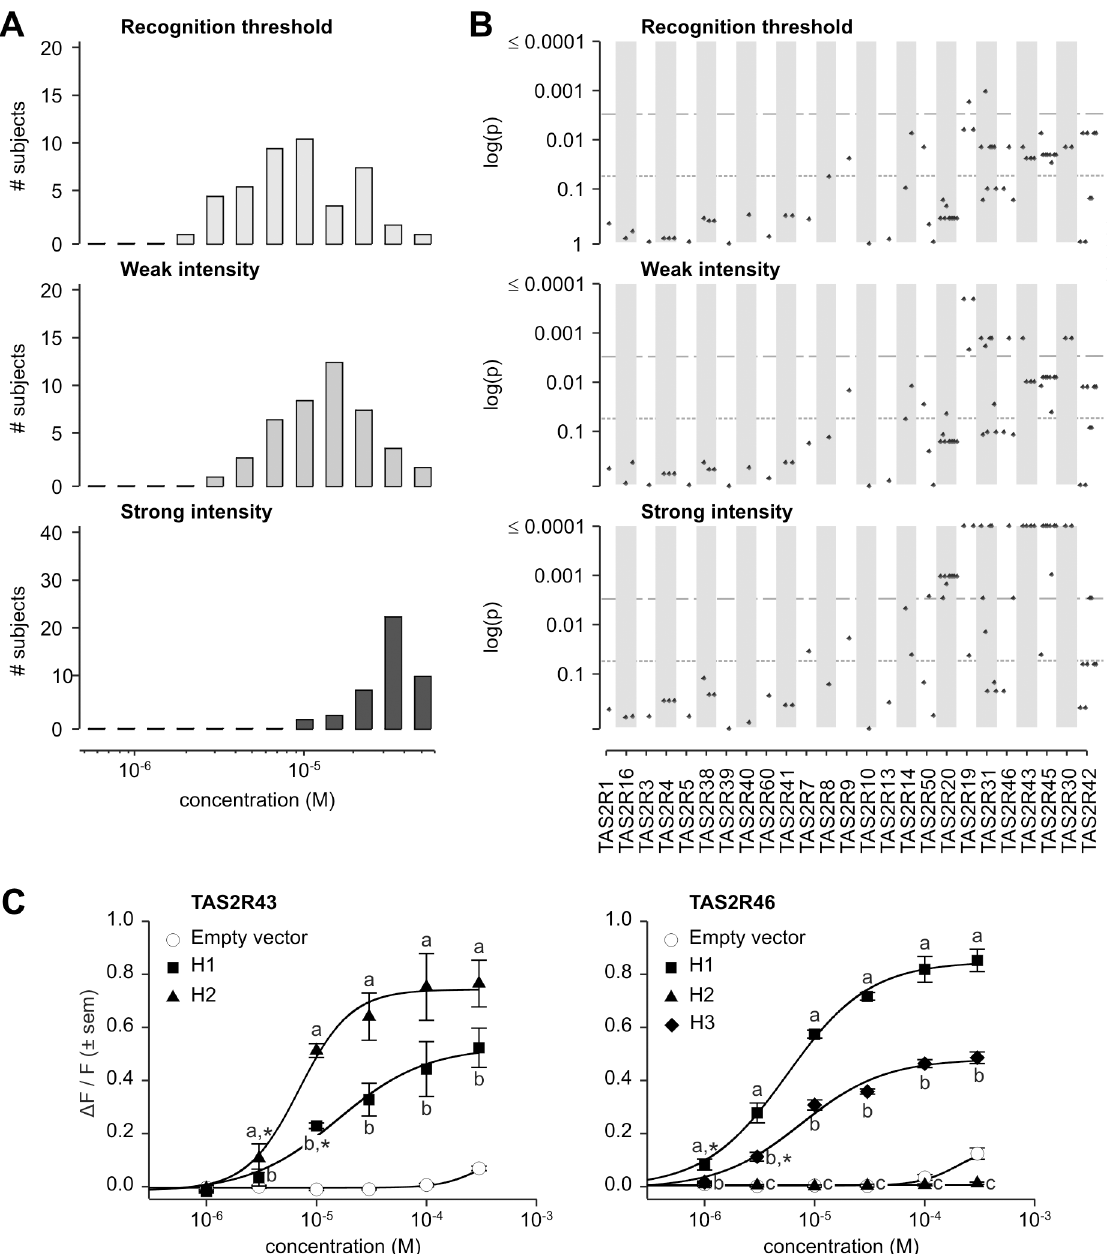
Fig 7. Grosheimin phenotypes, genotype-phenotype associations, and functional assays. (A) Distribution of bitter taste recognition thresholds, and concentrations perceived as weak and strong. (B) Genotype-phenotype associations for common SNPs (frequency > 0.05). Dashed line indicates significance threshold following corrections for multiple testing. Solid line indicates uncorrected significance threshold. (C) Allele-specific dose response curves for loci harboring SNPs showing significant phenotypic associations.